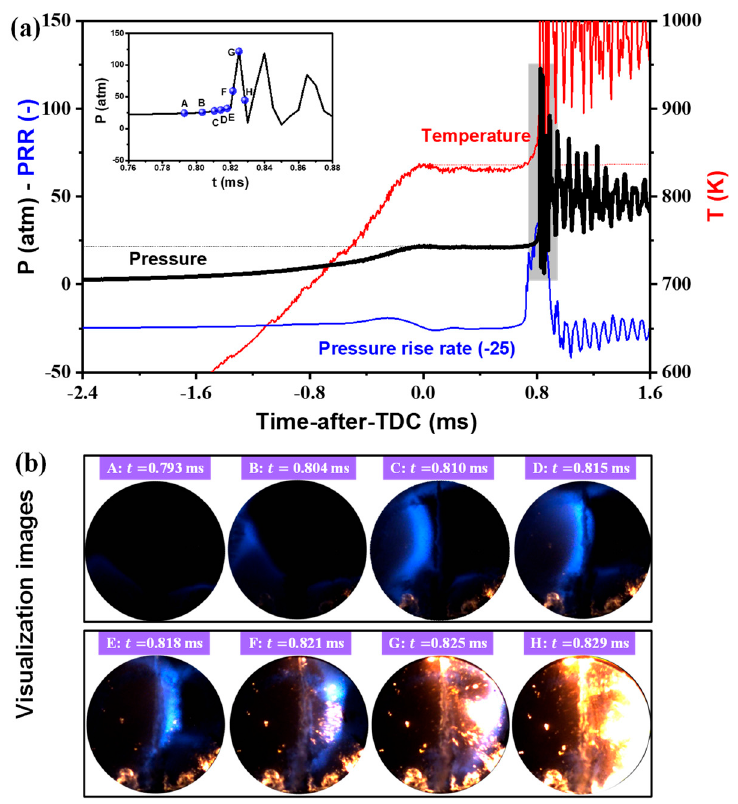
Figure 4. Traces of pressure, pressure rise rate, and temperature and visualization images of abnormal combustion at P c = 20 atm, δ = 1.5 ms, and P J = 60 MPa (corresponding to case (a) shown in Figure 3). ( a ) Pressure and pressure rise rate and ( b ) visualization images.